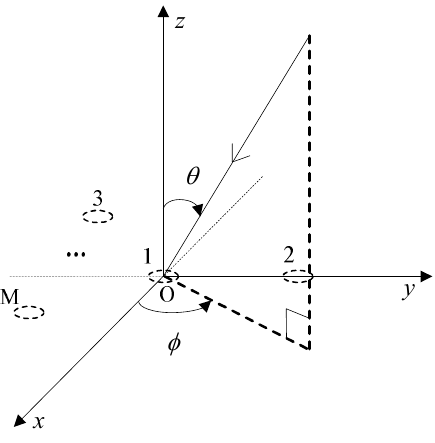
Figure 1. Schematic diagram of the array.